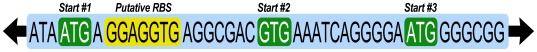
Potential comparison tool.Hypothetical comparison of start sites from multiple annotations, combined with species-specific RBS data. Start #2 would be the most likely start codon based on RBS spacing.